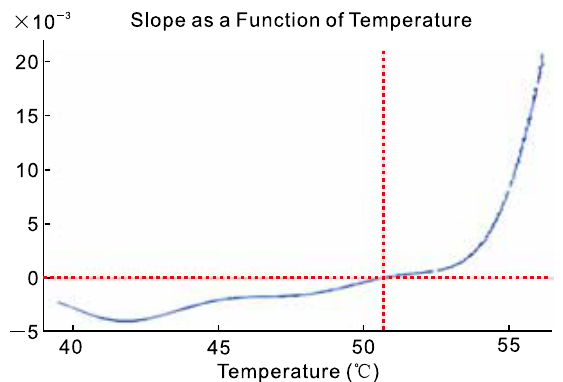
Figure 5 The slope of the thermal strain curve as a function of temperature